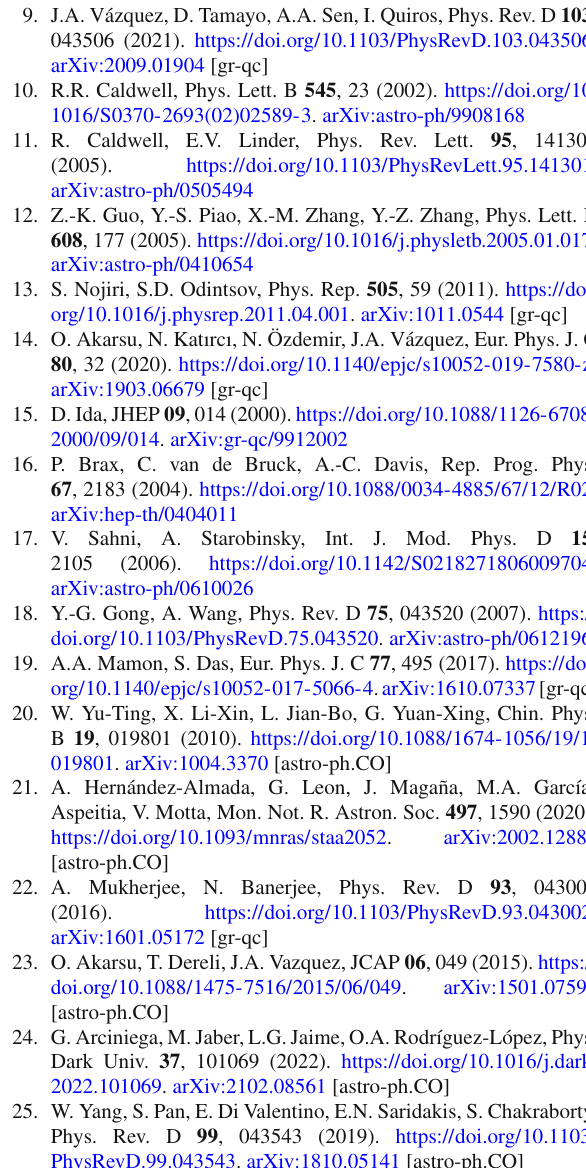
the 6 bin reconstruction, as represented by its (cid:7)χ 2